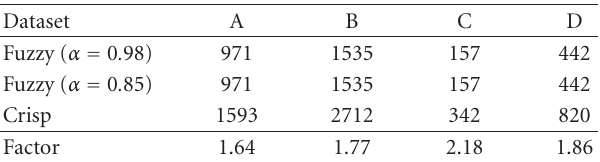
Table 7: Size of data sets after cuto ff s using two fuzzy thresholds ( α -cuts) and crisp cuto ff